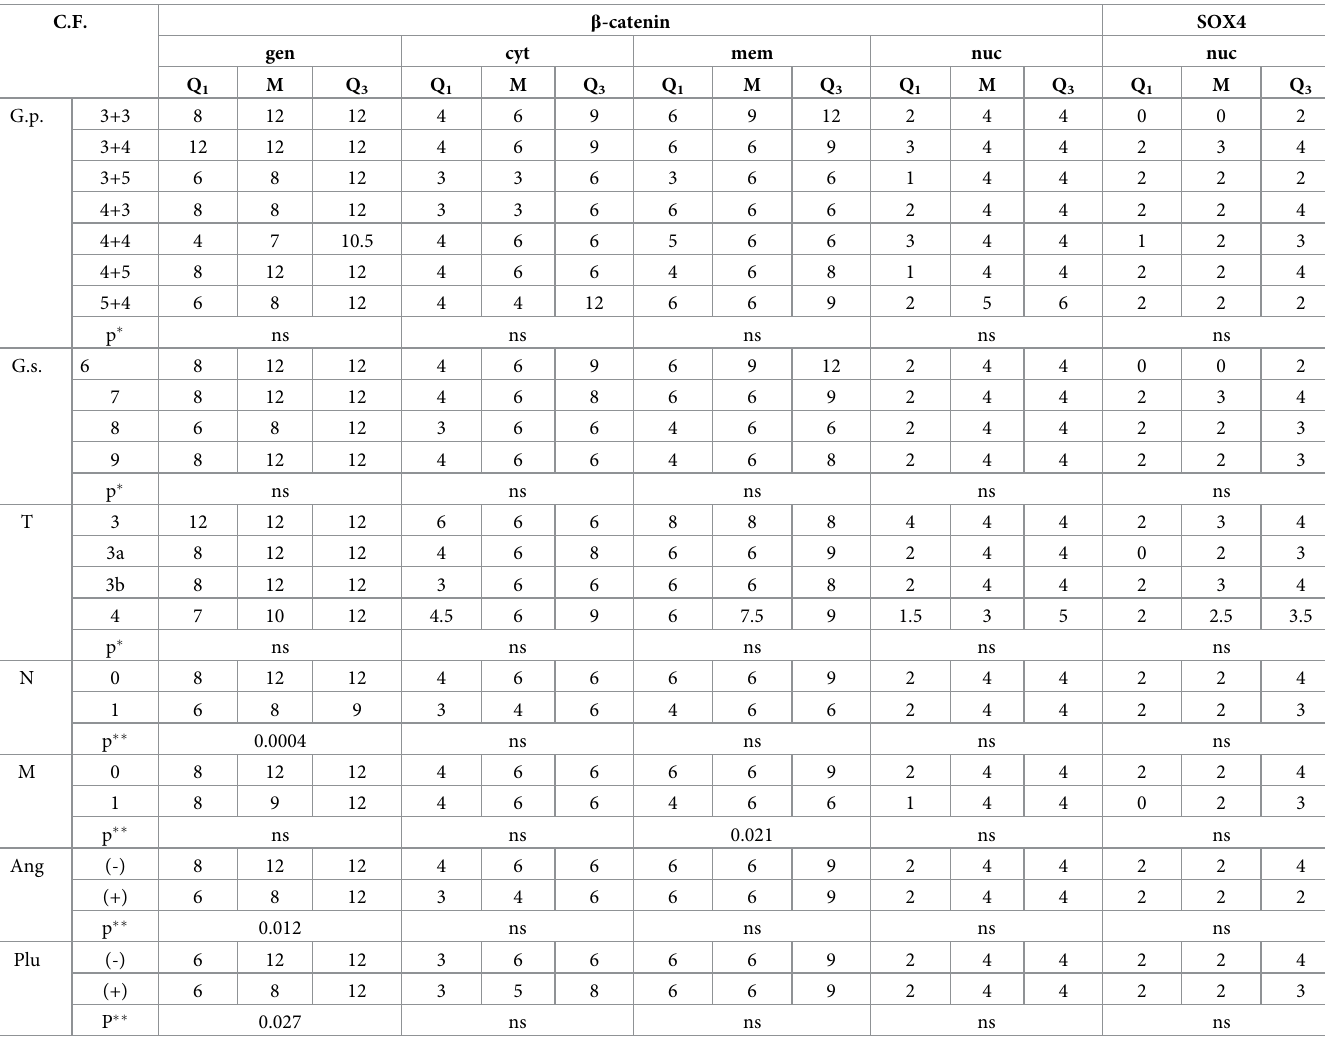
Table 3. Correlation between expression of β -catenin and SOX4 and clinicopathological features of prostate cancer.